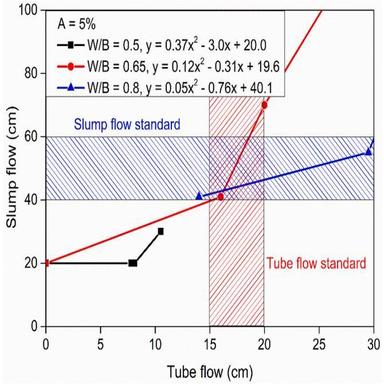
Relationship between slump flow and tube flow in CLSM with a constant A of 5%.